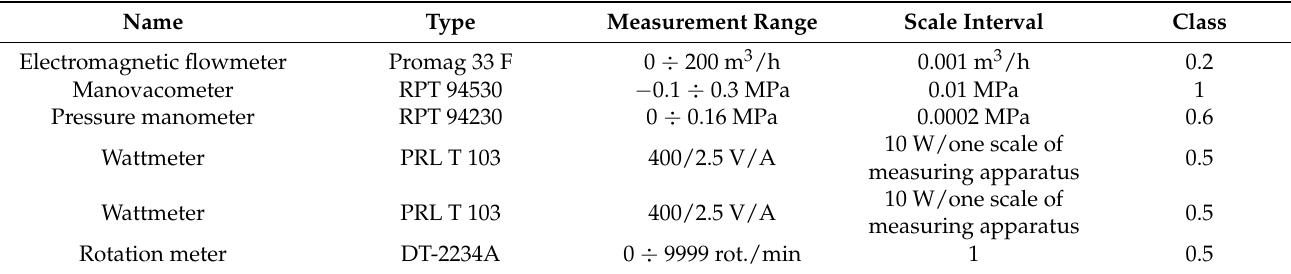
Table 4. Technical data of the DANTEC 60X laser anemometer.